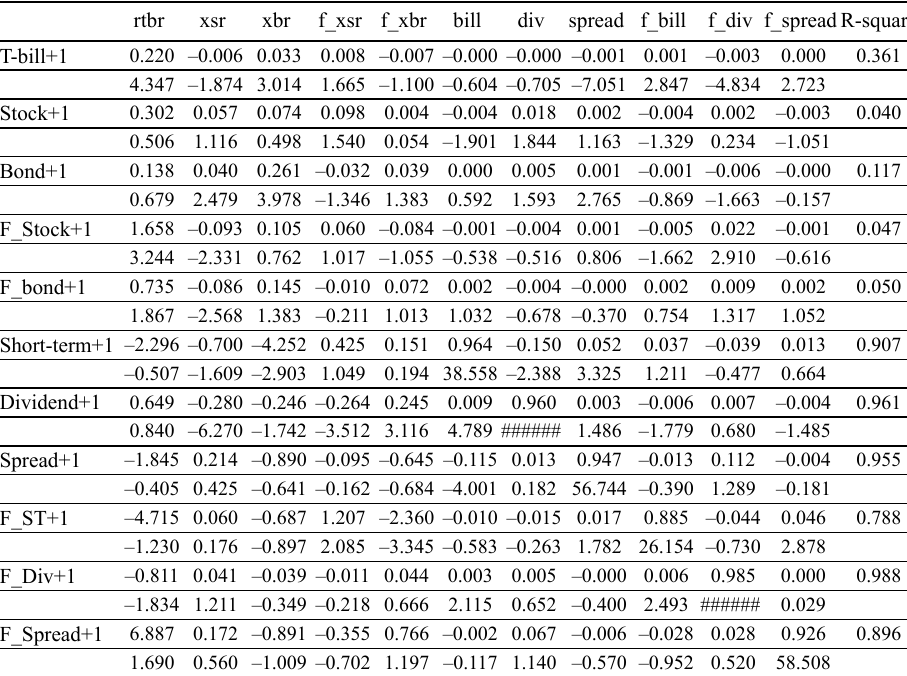
Table 9. An investor from SA who can invest in domestic assets and assets from the